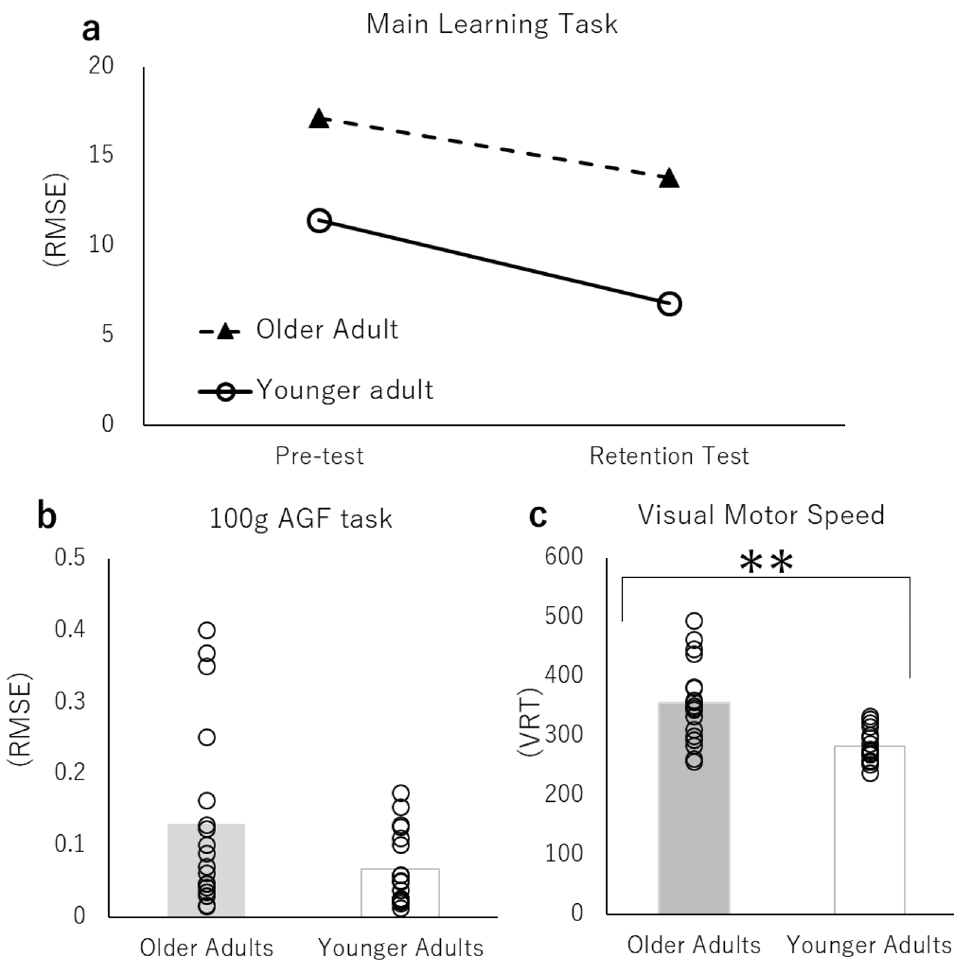
Figure 4. Results of each measurement item. ( a ) RMSE of the pre-test and the retention test (the main learning task), ( b ) Comparison of the 100 g AGF task, ( c ) comparison of VMS, (*p < 0.05, **p <